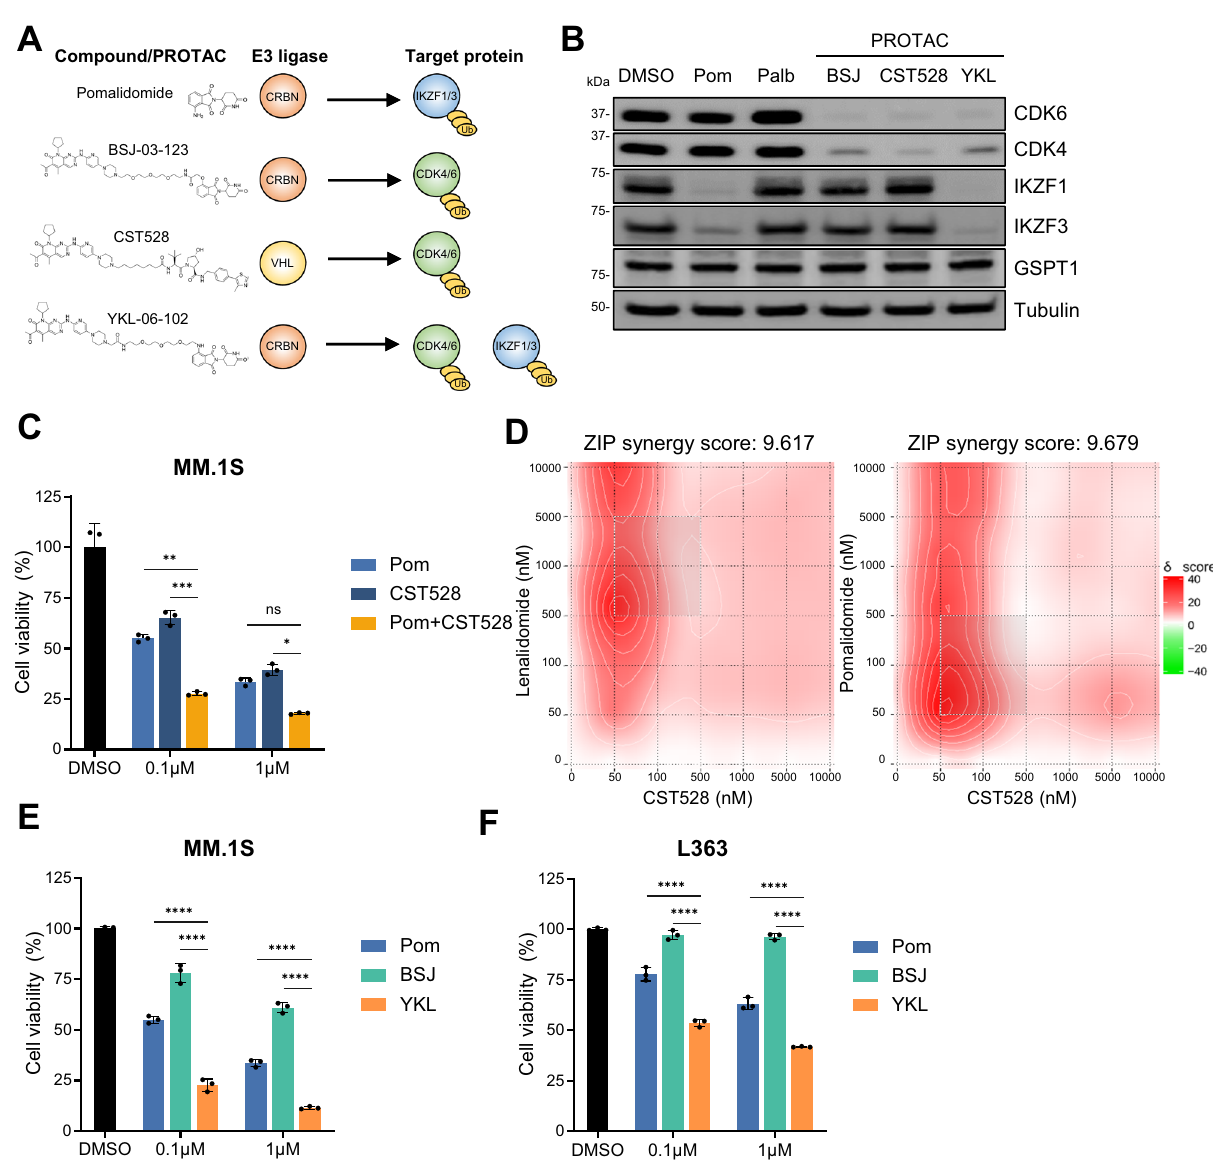
Fig. 4 CDK6 inhibition synergizes with IKZF1/3 degradation. A Chemical structure, hijacked E3 ligase, and targets of pomalidomide (pom), PROTAC BSJ- 03-123 (BSJ), PROTAC CST528, and PROTAC YKL-06-102 (YKL). B Western blot analysis of MM.1S cells treated with 1 µ M of pomalidomide, palbociclib, BSJ-03-123, CST528, and YKL-06-102 for 16 h ( N = 3 biologically independent replicates). C Cell viability of MM.1S cells treated 96 h with pomalidomide, CST528 and in combination ( N = 3 biologically independent replicates). D Synergy map of MM.1S cells treated with CST528 in combination with lenalidomide or pomalidomide. E Cell viability of 96 h treatment with pomalidomide, BSJ-03-123 and YKL-06-102 in MM.1S cells ( N = 3 biologically independent replicates) and F L363 cells ( N = 3 biologically independent replicates). Synergy levels are indicated with ZIP synergy scores. Synergy maps were generated with SynergyFinder 75 . Cell viability is normalized to respective DMSO conditions. Data represent the mean ± SD of biological triplicates. One-way ANOVA is applied. P values are displayed as follows: n.s. = P > 0.05; * P ≤ 0.05; ** P ≤ 0.01; *** P ≤ 0.001; **** P ≤ 0.0001. Source data are provided as a Source Data fi